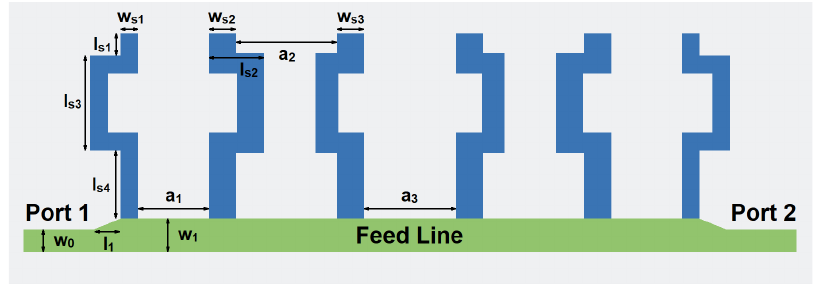
Figure 9. The topology of the SSPP structure with serpentine